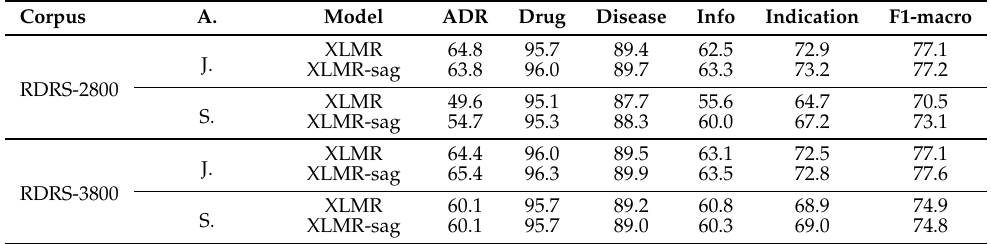
Table 9. Named-entity recognition accuracy on the RDRS dataset using joint (J.) and sequential